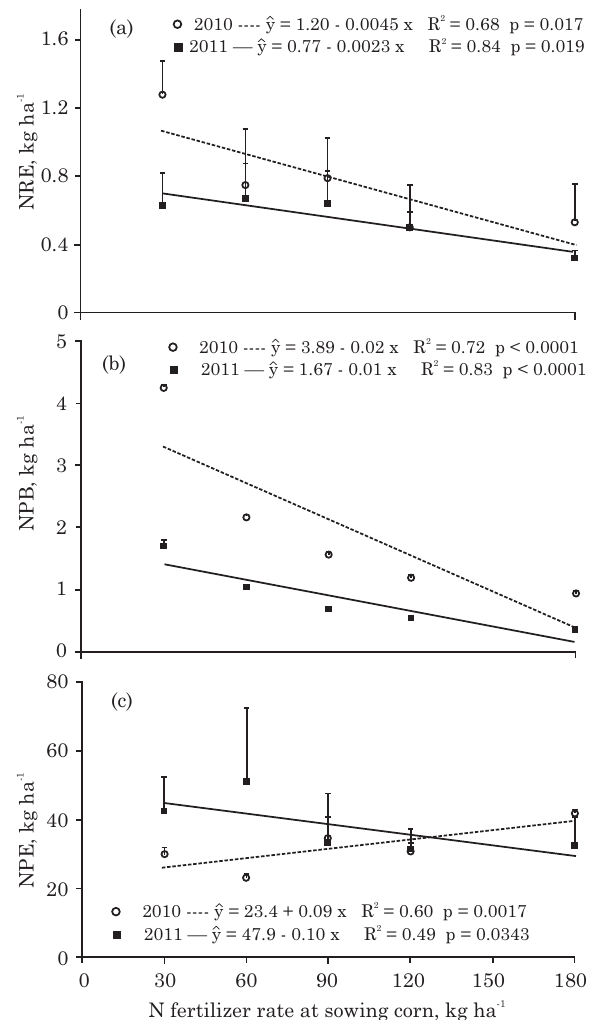
Figure 4. Nitrogen recovery efficiency (NRE) (a), nitrogen partial balance (PNB) (b) and nitrogen physiological efficiency (NPE) (c) affected by nitrogen fertilizer rates in the 2010 and 2011 growing seasons. The mean values of the data are shown with error bars that show the uncertainty of the